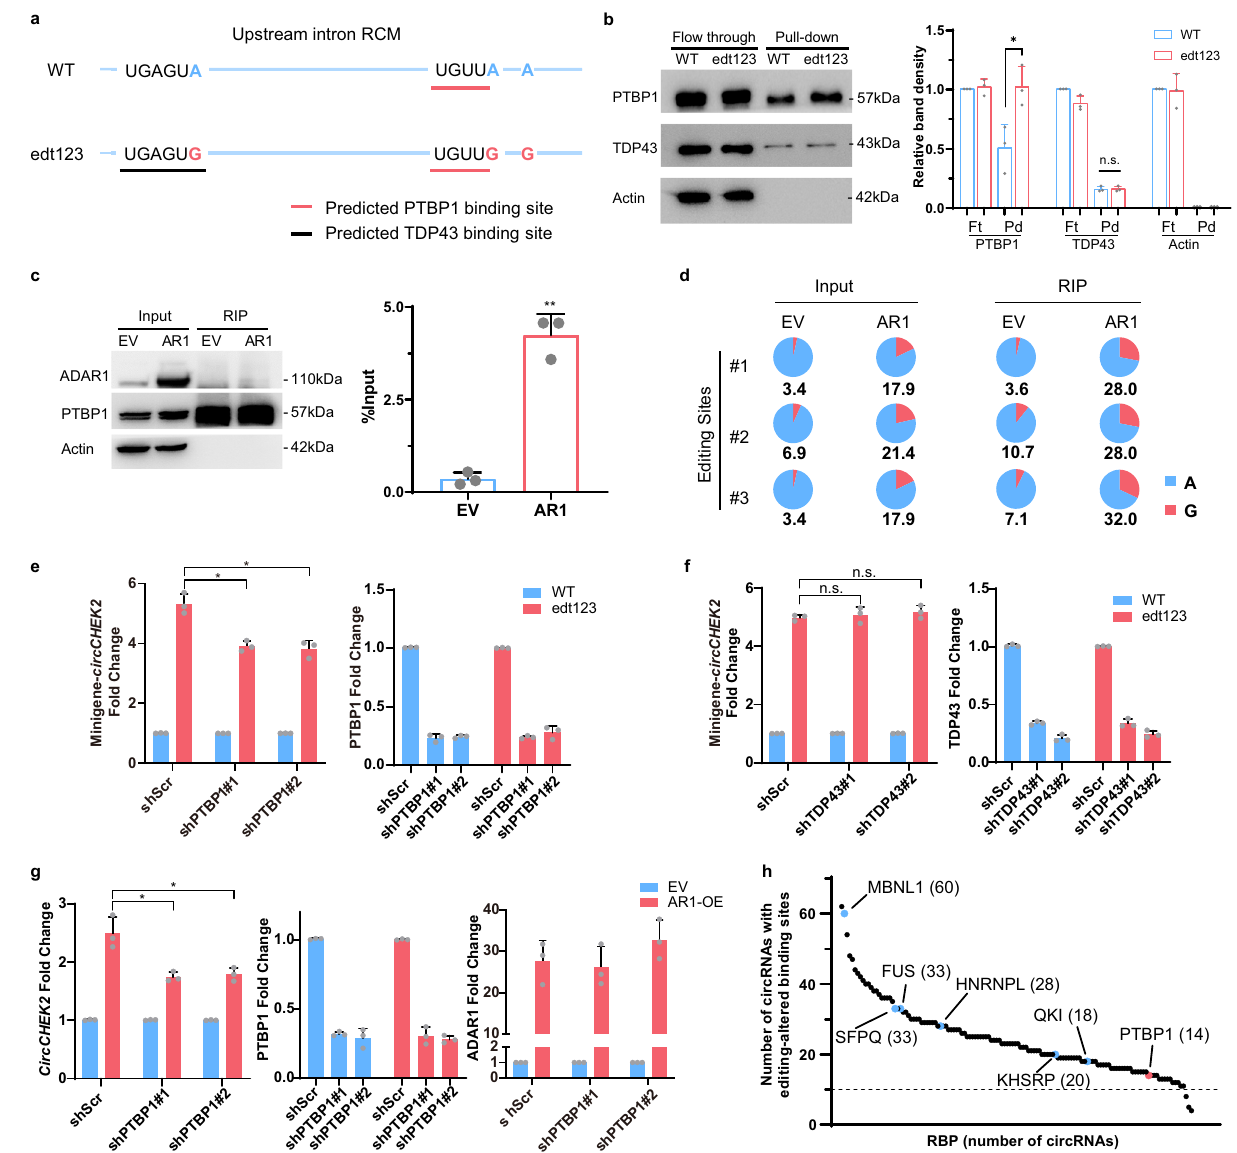
Fig. 5 A-to-I editing enhances PTBP1 binding to intron and promote circCHEK2 biogenesis. a In silico prediction of PTBP1 (red line) and TDP43 (black line) binding to unedited (WT) or triple mutated (edt123) RCM sequence of circCHEK2 using RBPmap. b WB analysis of RNA pull-down products showing the binding af fi nity of PTBP1 and TDP43 to the WT or edt123 RNA probes. c RIP-qPCR analysis of the binding of PTBP1 protein to the circCHEK2 RCM region in EC109 cells transfected with ADAR1 or empty vector control (EV). WB and qPCR analyses of PTBP1 RIP immunoprecipitates are shown in the left and right panels, respectively. d Pie charts illustrating the editing frequency (indicated by red slice) of each editing site (#1, #2, #3) in the indicated Input or RIP samples. Editing frequency of each editing site was measured using TA cloning (see Methods). e , f Left panels: Fold change in expression of circCHEK2 produced by minigenes with or without A-to-G mutations at three editing sties, upon knockdown of PTBP1 c or TDP43 d . Right panels: qPCR analysis showing the knockdown ef fi ciency of PTBP1 and TDP43. g Left panel: Fold change in expression of endogenous circCHEK2 with or without lentivirus- mediated overexpression of ADAR1 in EC109 cells, upon knockdown of PTBP1. Middle panel: qPCR analysis showing the knockdown ef fi ciency of PTBP1 in the indicated cells. Right panel: qPCR analysis illustrating the ef fi ciency of ADAR1 overexpression in the indicated cells. b , c , e , f , g Each dot represents the mean of technical triplicates. Data are presented as mean ± S.D. of 3 biological replicates (paired, two-tailed Student ’ s t -test. n.s., not signi fi cant; * P < 0.05; ** P < 0.01). h Number of editing-dependent ARcircs of which fl anking introns have editing-mediated changes in the binding sites of each RBP. Black dots indicate RBPs included in this analysis and the number in the bracket denotes the number of circRNAs with altered binding motifs of the corresponding RBP due to editing in fl anking introns. Those which have been previously reported to regulate circRNA biogenesis are highlighted in blue. PTBP1 is highlighted in red. Exact P values and source data are provided in Source Data fi